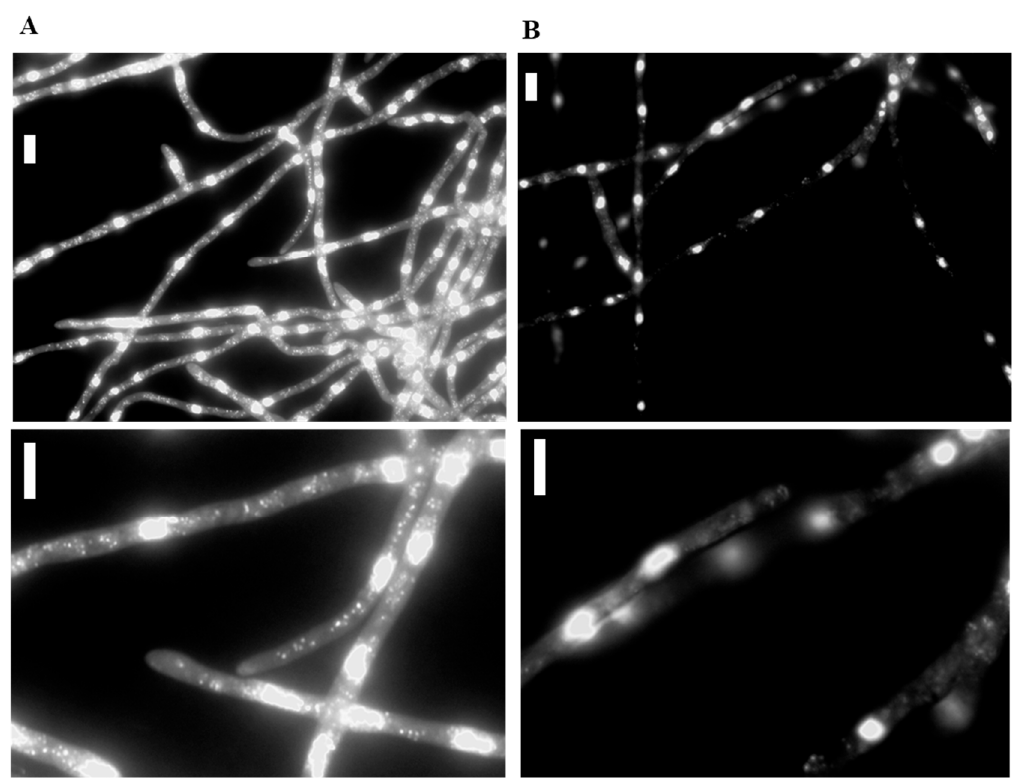
Figure 7. DAPI staining (blue, but shown in BW to give higher contrast for eyes) of hyphae with too long exposure to show nuclei well that contain a lot of DNA and become “overexposed” but can show bacteria and weakly also mitochondria that contain DNA. ( A ) With potential facultative endohyphal bacteria, ( B ) without potential facultative endohyphal bacteria. The lower images show higher magnification with hyphal tips where low-fluorescent active mitochondria should be positioned. These can be seen (B lower image). The bacteria containing hyphae (A lower image) are much brighter, thus it is difficult to see the mitochondria since the nuclei are very brightly stained and illuminate the cytoplasm that scatters light. That is why the cytoplasm is seen as a “darkfield” microscope illumination. Ordinary fluorescent microscopy using DAPI filters and 40× objective was used to have more hyphal biomass in one image and a deeper focal depth, since that facilitates detection of the bacteria in more of the cytoplasm. No bacteria were seen attaching to the edges of the hypha as is normally seen for bacteria associating with hyphal cell walls. Size bars = 20 μ m.